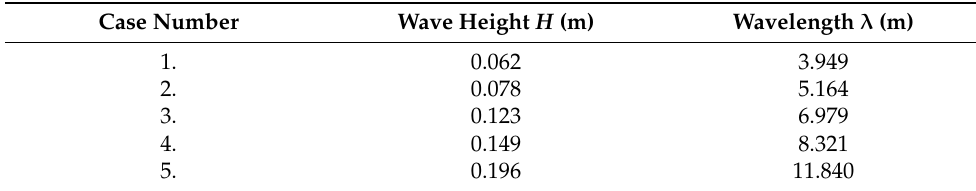
Table 3. Wave conditions for KRISO containership benchmark study.